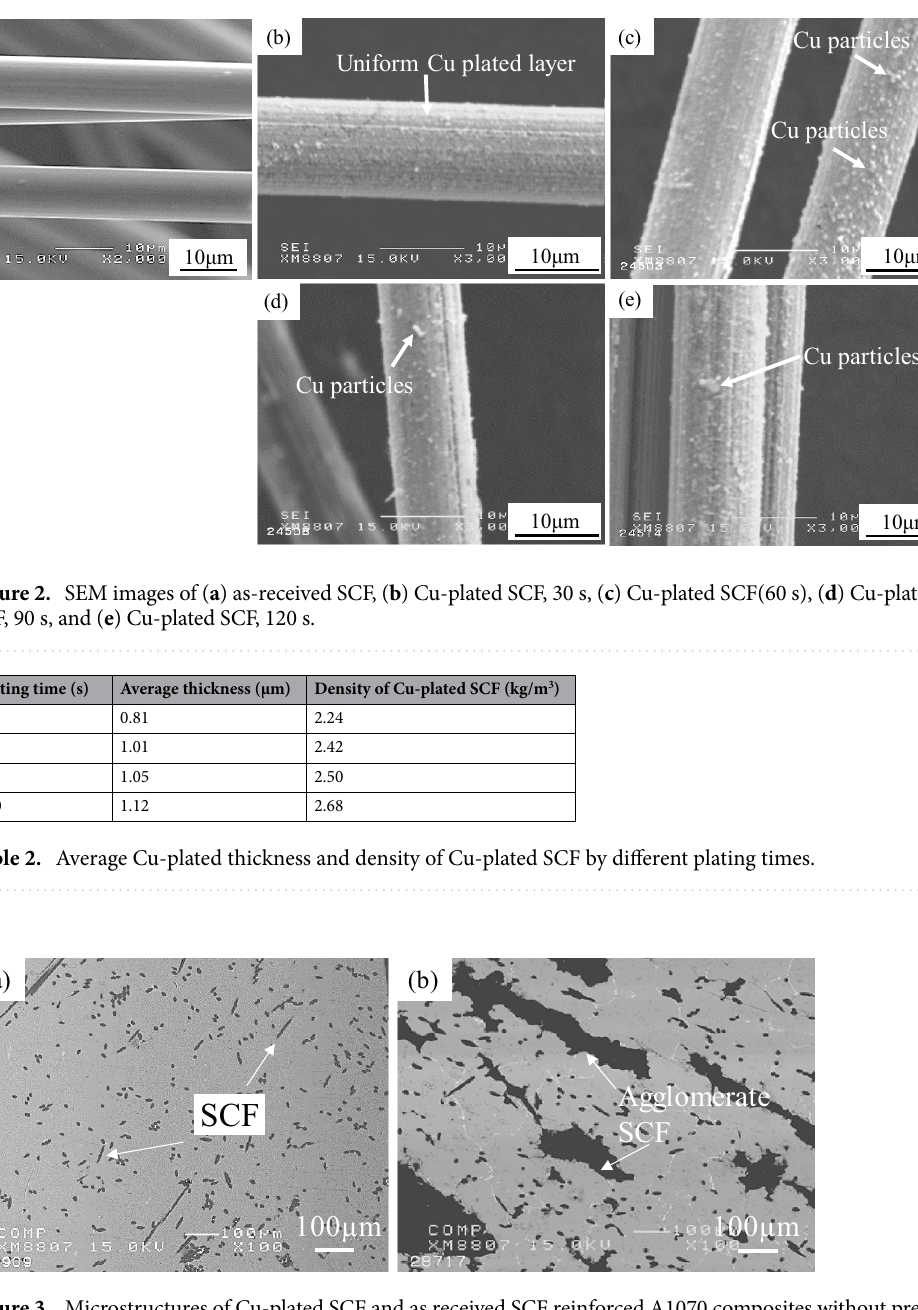
Figure 3. Microstructures of Cu-plated SCF and as received SCF reinforced A1070 composites without preform manufacturing under pressure of 0.8 MPa: ( a ) Cu-plated SCF, ( b ) as-received SCF without Cu